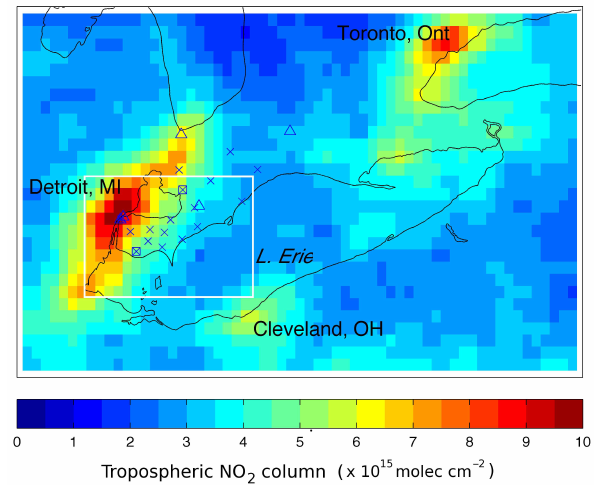
Fig. 1. NO 2 monitoring sites for the 2007 BAQS-Met campaign. Passive monitoring locations are denoted by black-and-white cir- cles. High-time resolution chemiluminescence monitor locations are marked by yellow bubbles with text labels. Chatham, Wind- sor West and Windsor Downtown were Ontario Ministry of the En- vironment (MoE) permanent monitoring stations. Harrow, Pelee and Ridgetown also had monitors operated by MoE from 20 June to 10 July. Harrow had a photolytically converted chemilumines- cence monitor operated by Environment Canada from 1 June to 10 September and Bear Creek had both molybdenum and photolyt- ically converted monitors operated by Environment Canada for the same period. Two additional MoE permanent monitoring station not shown by this map were also used (Sarnia and London).